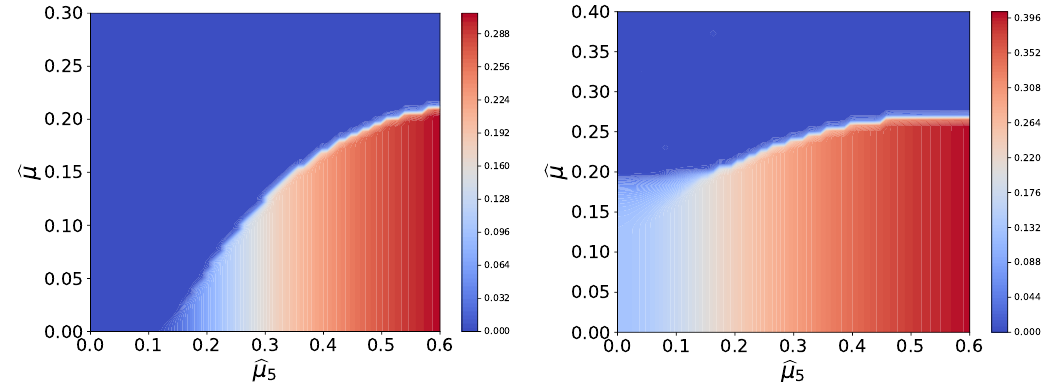
Figure 2. Phase diagrams for g = 17 . 5 (left) and g = 20 . 5 (right) at zero temperature. The color scale represents M